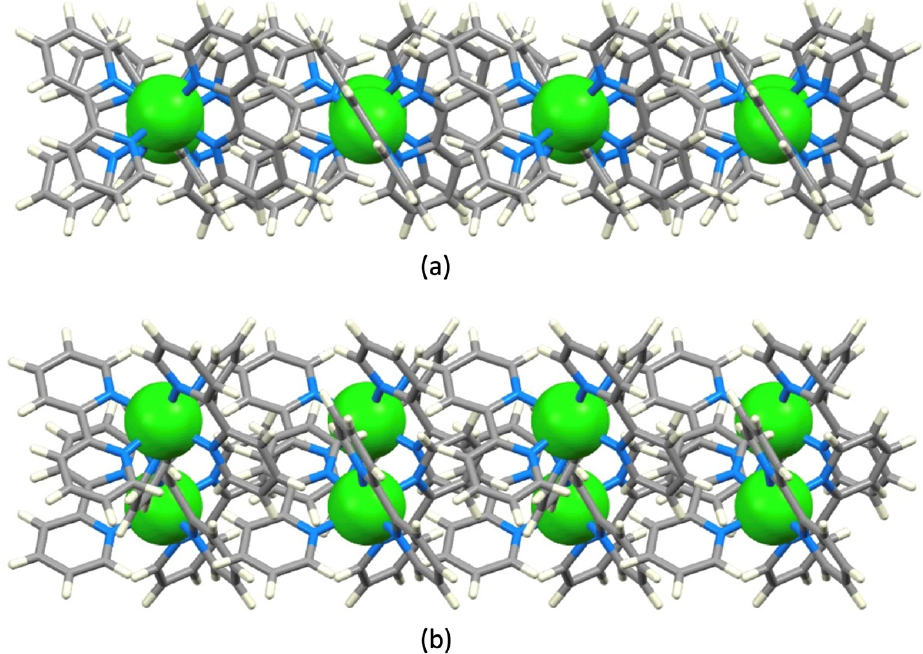
Figure 10. ( a ) Type II sheet of ( Λ )-[Zn(bpy) 3 ] 2+ cations in ( Λ )-[Zn(bpy) 3 ][ClO 4 ] 2 . H 2 O emphasizing the near coplanarity of the Zn(II) centers. ( b ) The second independent sheet of ( Λ )-[Zn(bpy) 3 ] 2+ cations which has a ‘ruffled’ profile (CSD refcode YUMJIZ [71]). Both sheets are viewed along the crystallographic b -axis and perchlorate ions and water molecules are omitted.